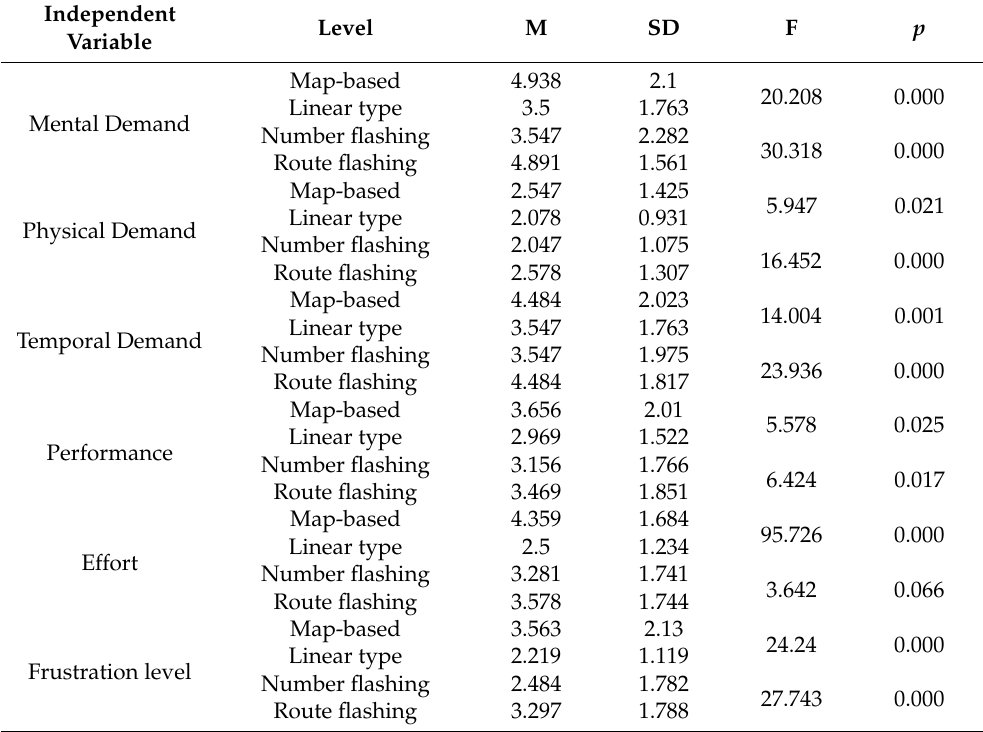
Table 5. Descriptive Statistics of Cognitive